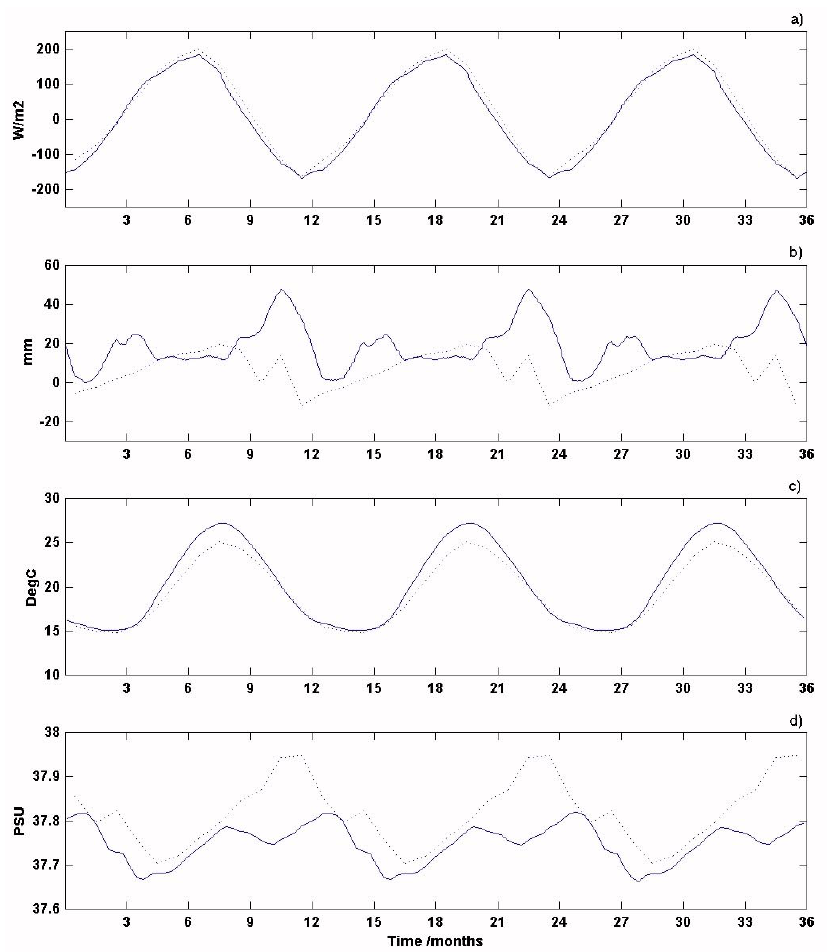
Fig. 7. Time series of surface averaged (a) total heat flux, (b) evaporation mi- nus precipitation ( E − P ), (c) temper- ature and (d) salinity. Modelled values (solid line), monthly climatological val- ues plotted on the 15th day of the month (dashed